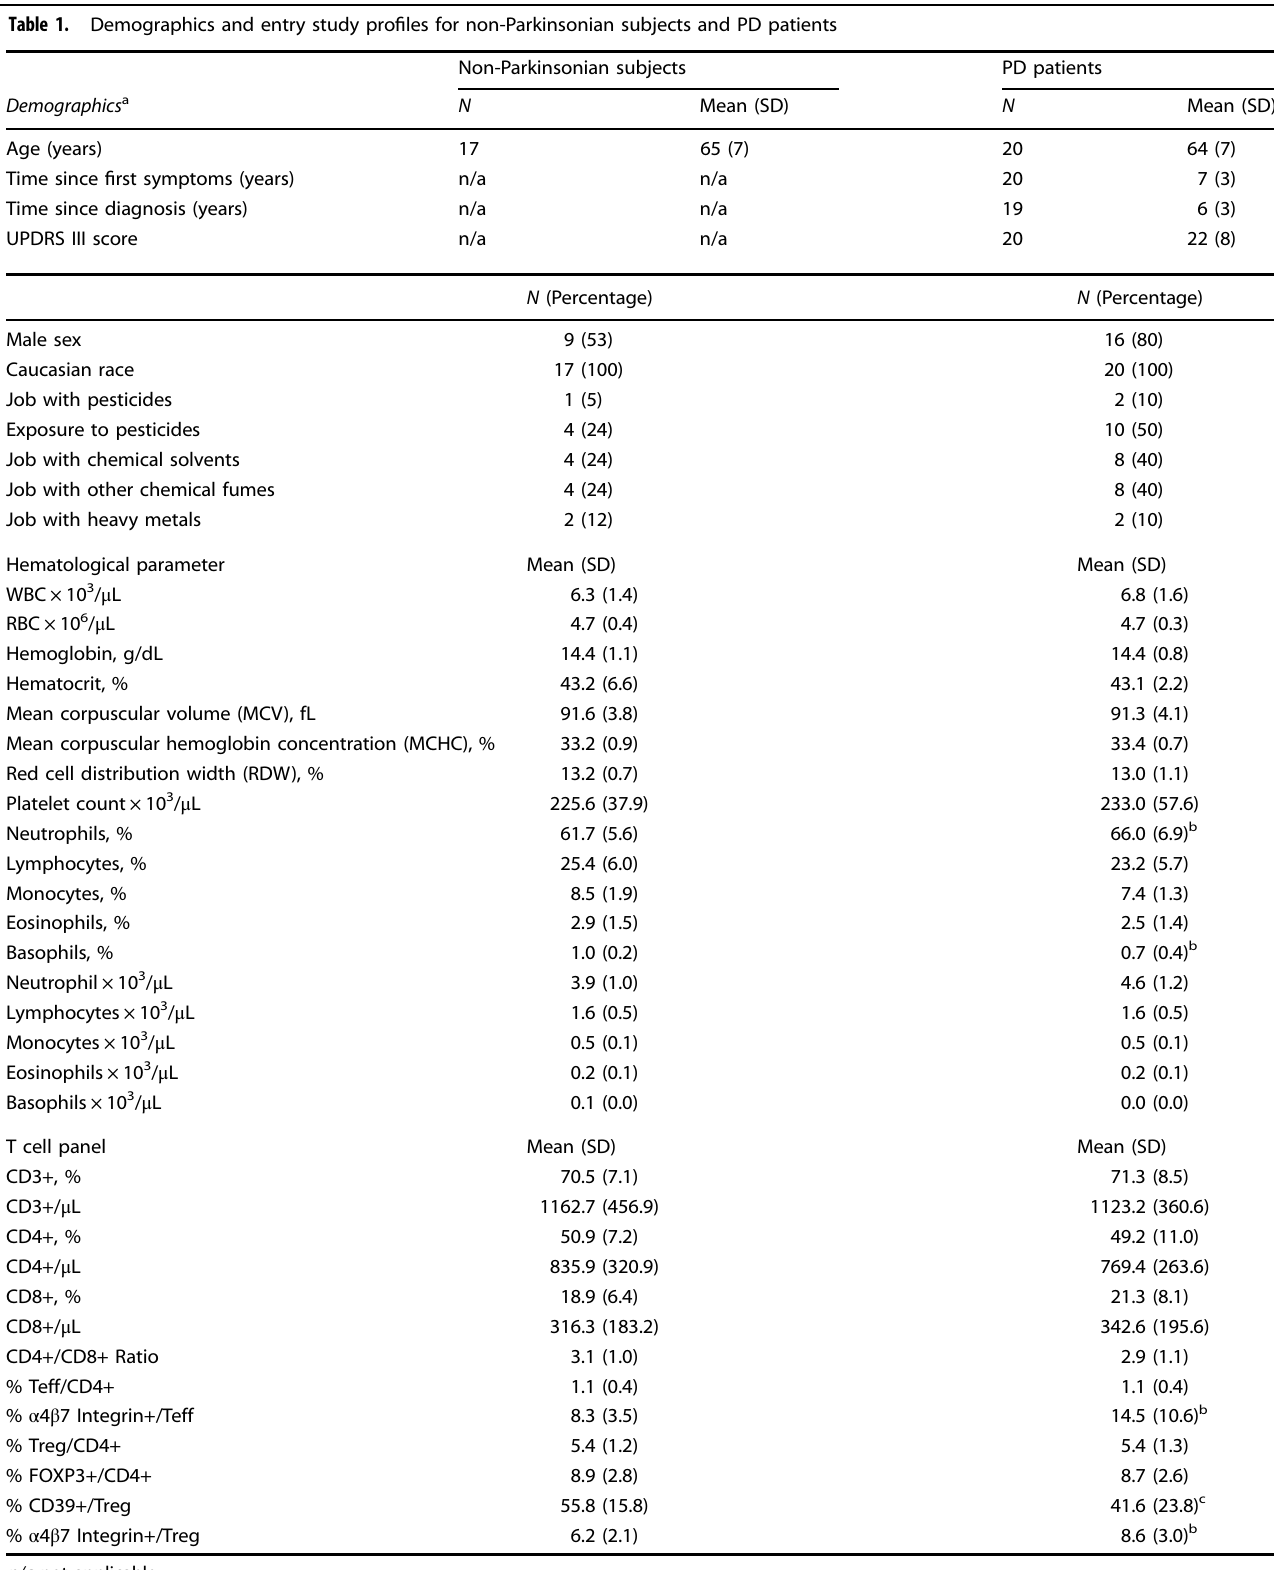
Table 1. Demographics and entry study pro fi les for non-Parkinsonian subjects and PD